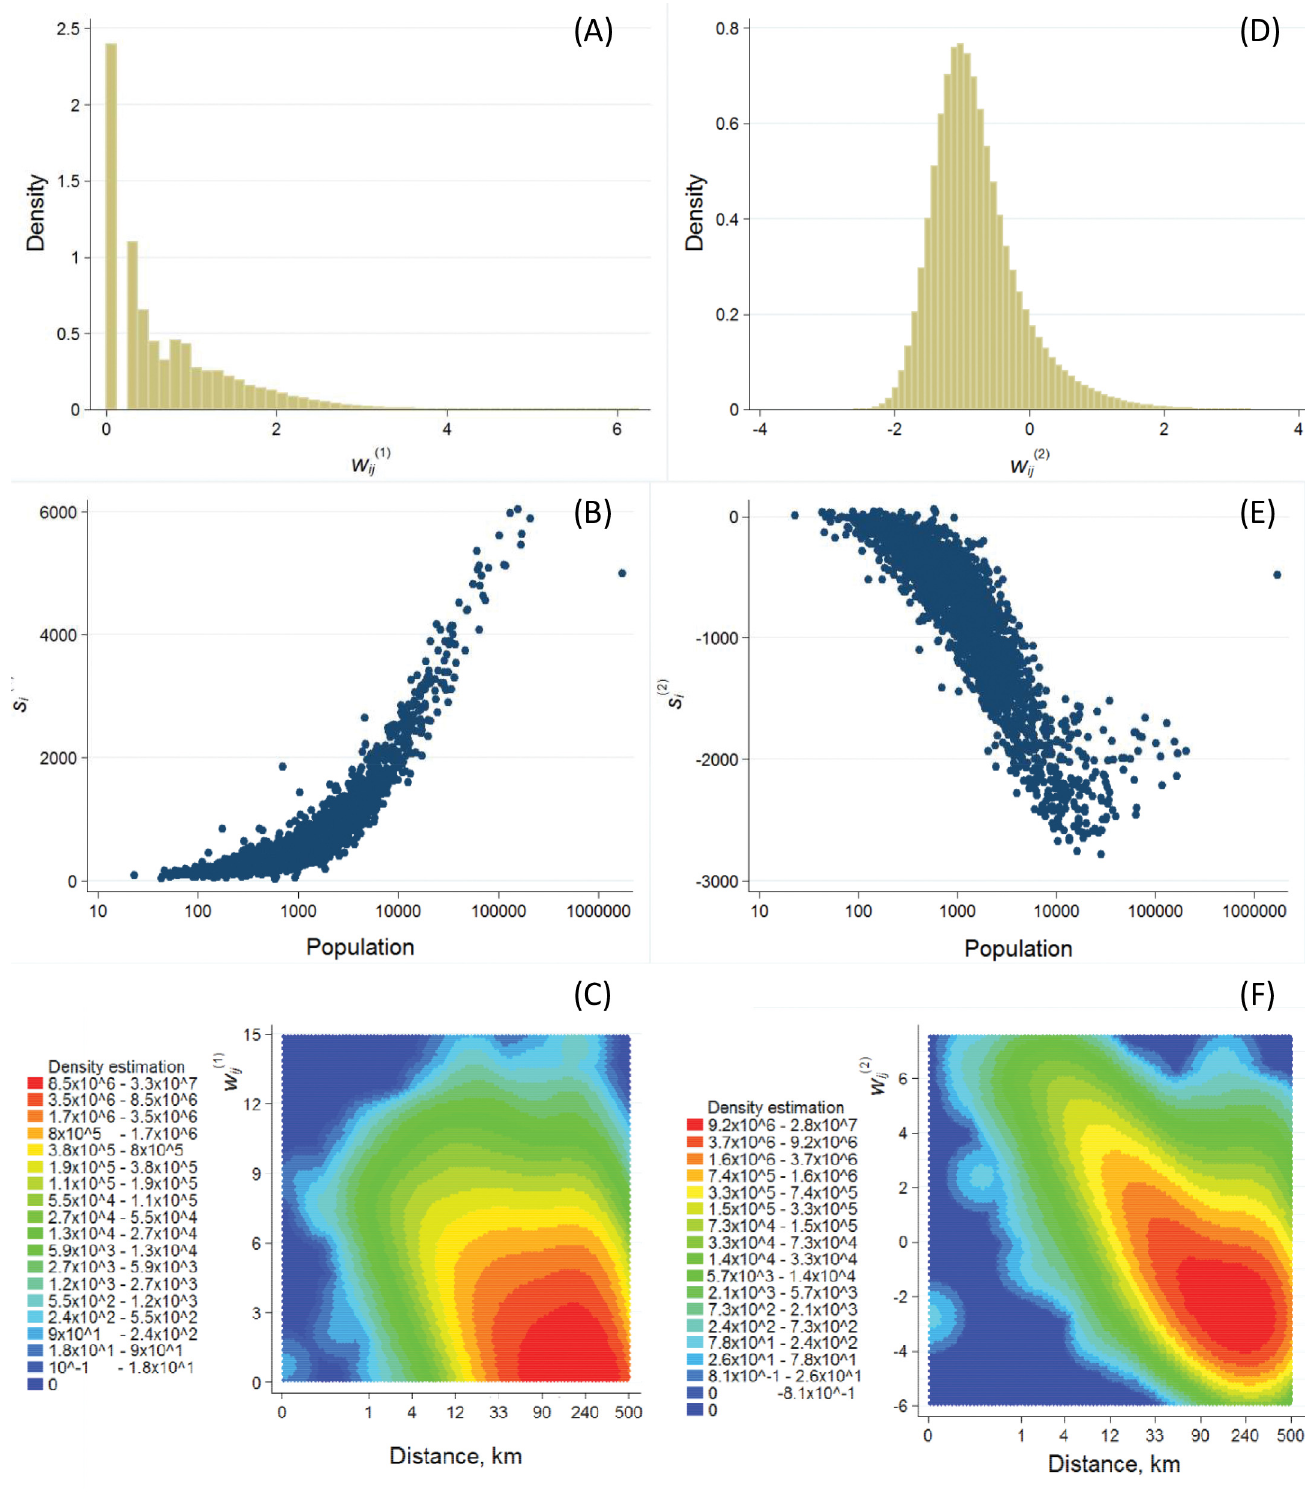
Fig 3. Edge weight and node strength distributions. (A) The distribution of w ð 1 Þ ij weights is unimodal and with a maximum at the value of 1. The tail ends at 7.68 indicating that a large fraction of the ties represent very low number of connections compared to a small set of high links indicating large number of